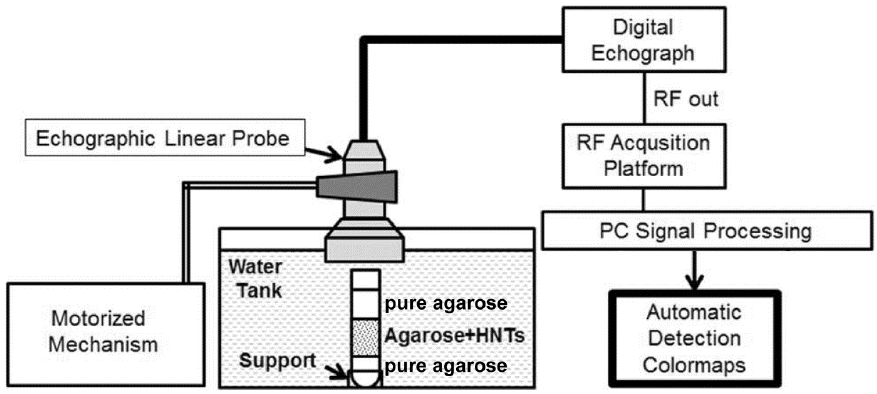
Figure 6. Scheme of the experimental data acquisition setup.